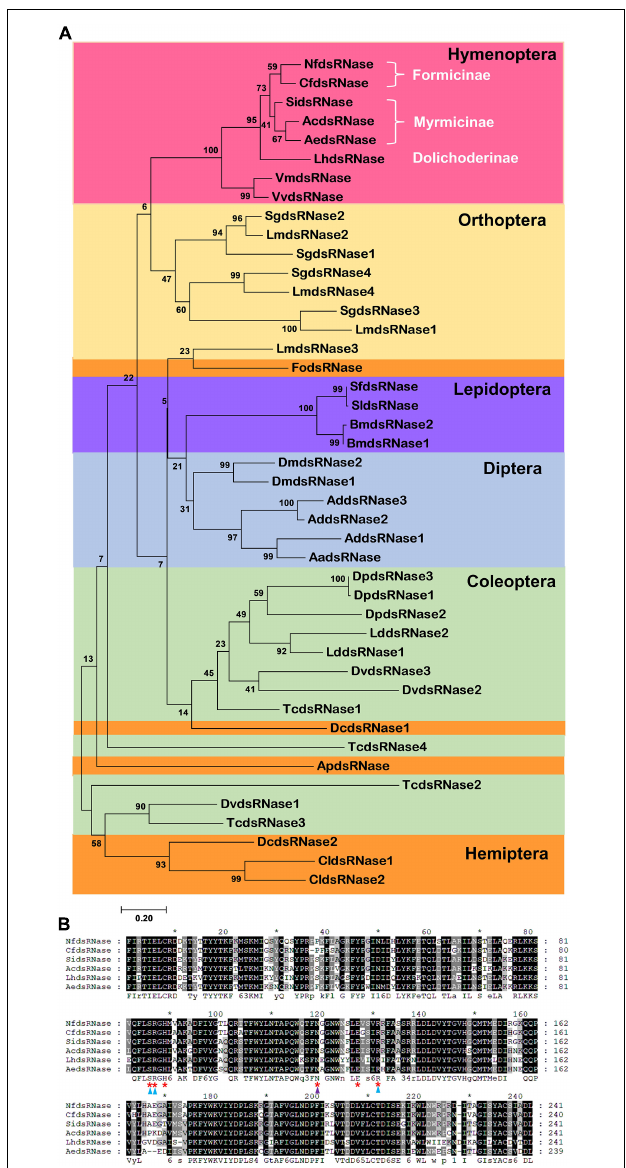
FIGURE 3 | Phylogenetic analysis of insect dsRNases. (A) The phylogenetic tree of dsRNase proteins from insects belonging to six orders was constructed by MEGA 7.0 using Maximum Likelihood method. The confidence values (%) of each branch on the phylogenetic trees were calculated based on 1000 bootstrap replicates. Different shadings represent different insect orders. Coleoptera: Dp, Dendroctonus ponderosae ; Dv, Diabrotica virgifera virgifera ; Ld, Leptinotarsa decemlineata ; Tc, Tribolium castaneum . Diptera: Aa, Aedes aegypti ; Ad, Anopheles darlingi ; Dm, Drosophila melanogaster. Hemiptera: Ap, Acyrthosiphon pisum ; Cl, Cimex lectularius ; Dc, Diaphorina citri ; Fo, Frankliniella occidentalis . Hymenoptera: Ac, Atta cephalotes ; Ae, Acromyrmex echinatior ; Cf, Camponotus floridanus ; Lh, Linepithema humile ; Nf, Nylanderia fulva ; Si, Solenopsis invicta .; Vv, Vespula vulgaris ; Vm, Vespa mandarinia . Subfamilies are also marked. Lepidoptera: Bm, Bombyx mori ; Sf, Spodoptera frugiperda ; Sl, Spodoptera littoralis . Orthoptera: Lm, Locusta migratoria ; Sg, Schistocerca gregaria . (B) Multiple sequence alignment of the DNA/RNA non-specific endonuclease domains in ant dsRNases. Red asterisks indicate the active sites. Substrate- and Mg 2 + -binding-sites are marked with blue and purple triangles, respectively.